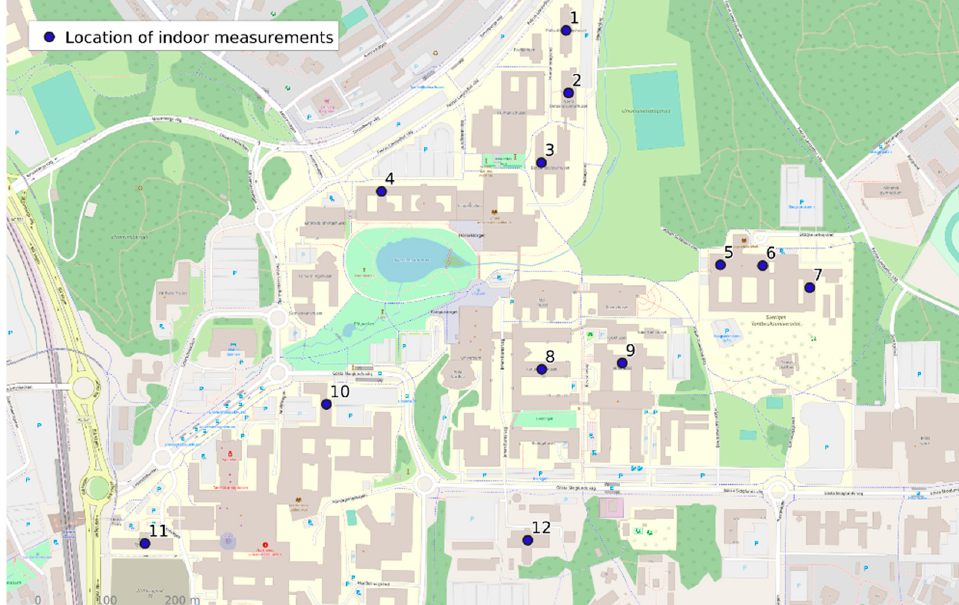
Figure 1. The study area with the location of Buildings 1–12, where indoor measurements were carried out. Basemap: © OpenStreetMap contributors.